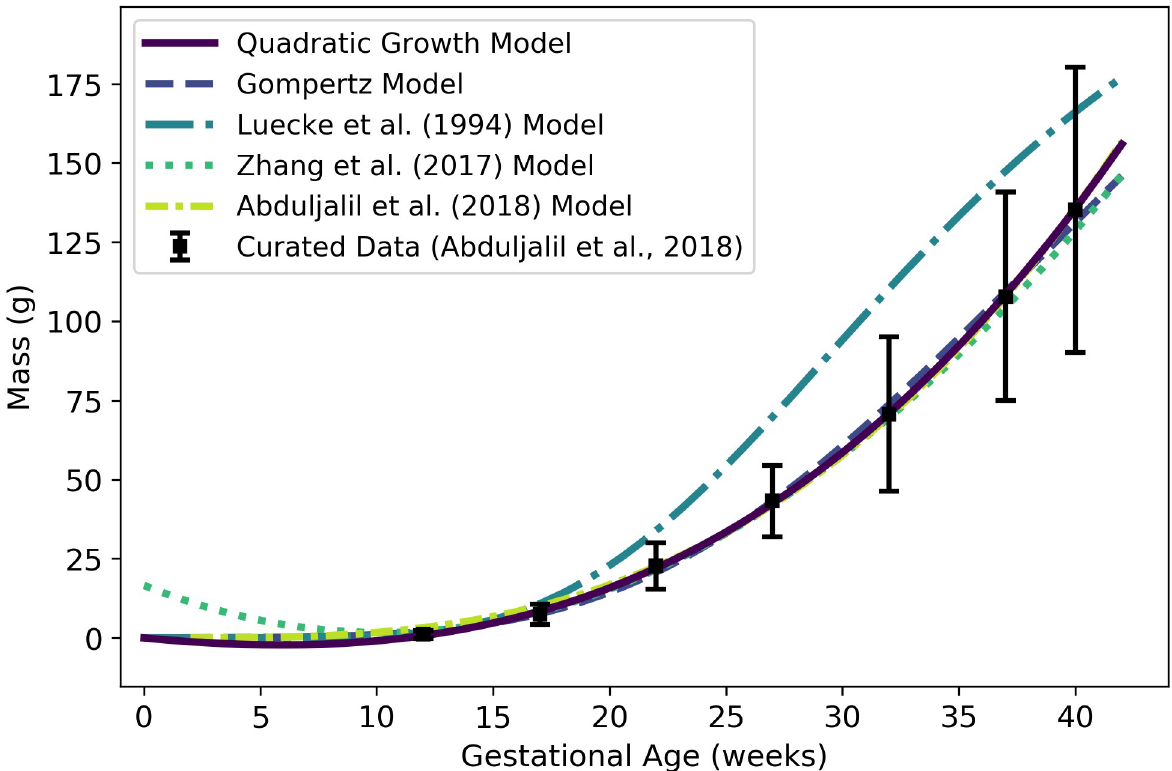
Fig 16. Fetal liver mass vs. gestational age. The cubic growth model (solid line) given by Eq 31 was selected as the most parsimonious model in our analysis; however, that model gives negative liver mass values during early gestation. The Gompertz model (dashed line) given by Eq 32 is strictly positive on the time domain of interest. The model of Luecke et al. [15], which is a power law model based on fetal mass, was calibrated using a different data set [25]. The model of Zhang et al. [32] was also calibrated using a distinct compiled data set. The Zhang et al. [32] model describes liver volume, so the units were converted assuming a tissue density of 1